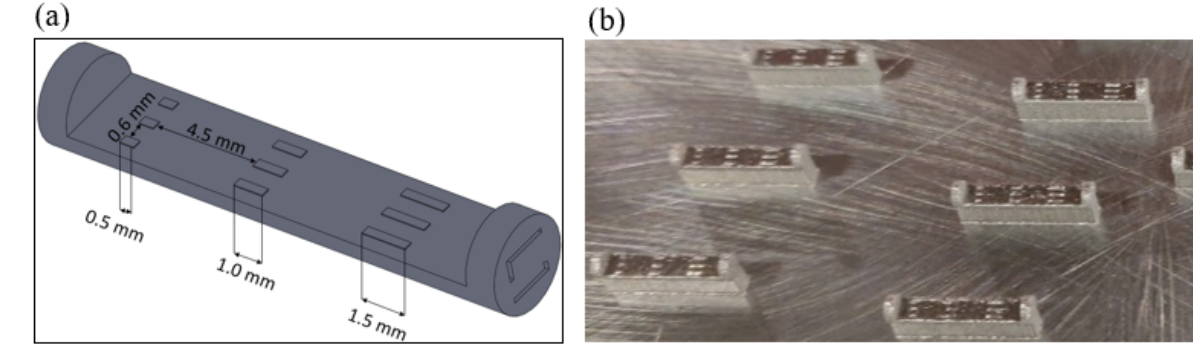
Figure 2. ( a ) Single layer designed on top of the semi-cylindrical base, and ( b ) single layer samples fabricated using EOS M270.